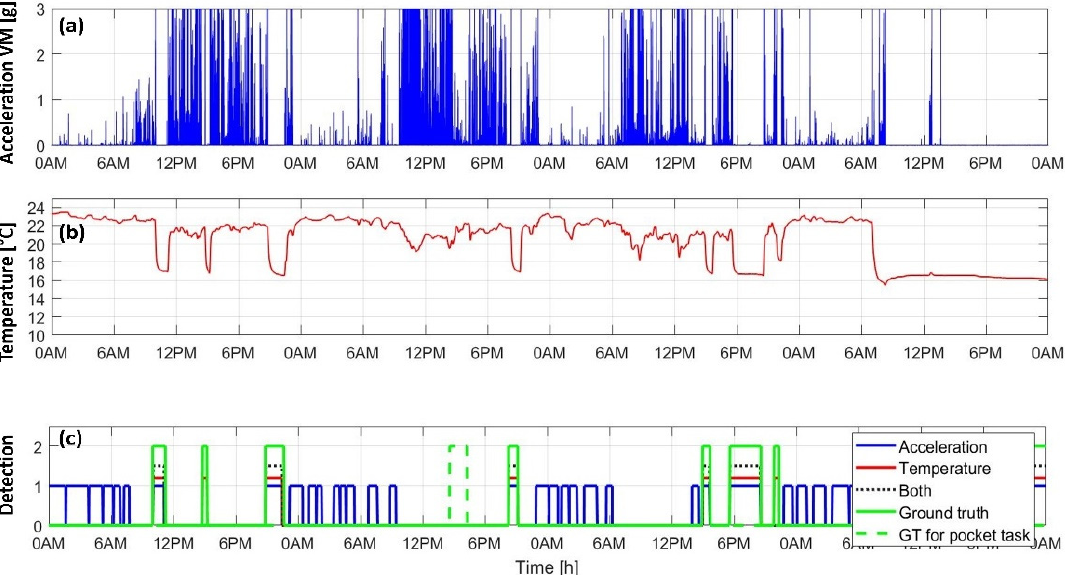
Figure 6. Illustrative example of processed sensor signals and the output of sensor non-wear detection algorithms: the filtered acceleration vector magnitude ( a ), the filtered and downsampled temperature signal ( b ), and the output of four different algorithms (based on accelerometer only, temperature only, or a combination of the two sensors) along with the ground truth extracted from participants’ diaries ( c ).